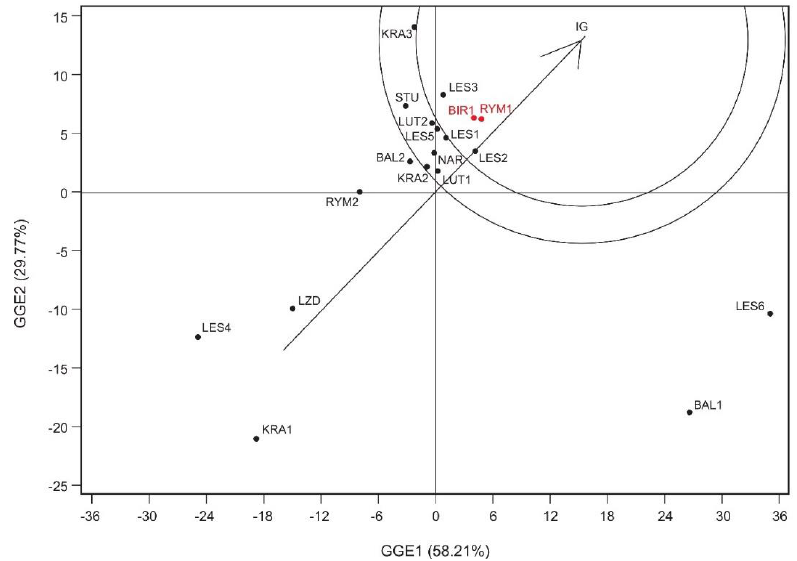
Figure 6. Comparison of all genotypes with the theoretical ideal genotype (IG). Position of the BIR1 and RYM1 populations, closest to the IG point marked in red.